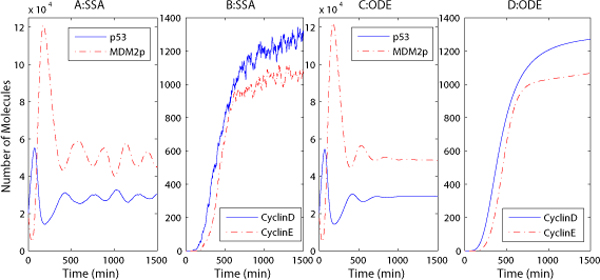
HMGB1 baseline simulation. Number of p53, MDM2p (A, C), CyclinD/E (B, D) molecules versus time for baseline simulations with SSA (A-B) and ODE (C-D) models.